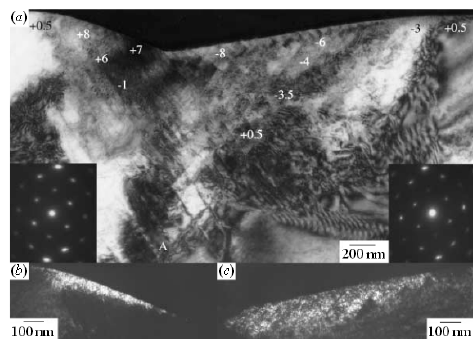
Figure 16. ( a ) Bright field image of a 50 mN indent in spinel with lattice rotations (in degrees) at selected positions indicated; ( b , c ) are dark field images of the surface of the same indent taken using streaks from either side of the 004 reflection [42]. Reproduced with permission from S.J. Lloyd et al., Proceedings of the Royal Society A; published by The Royal Society, 2005.